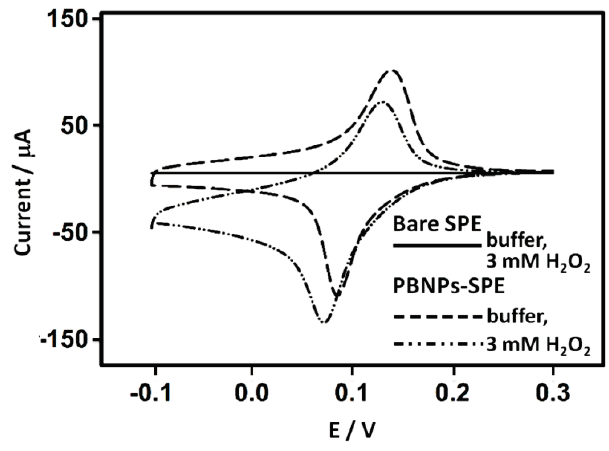
Figure 8. Mechanism of the catalytic H